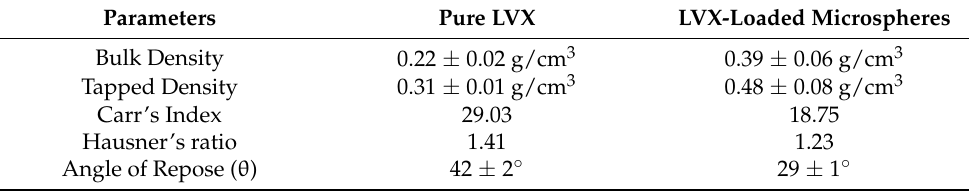
Table 2. Micromeritic properties of free LVX and optimized LVX-loaded microspheres. Parameters